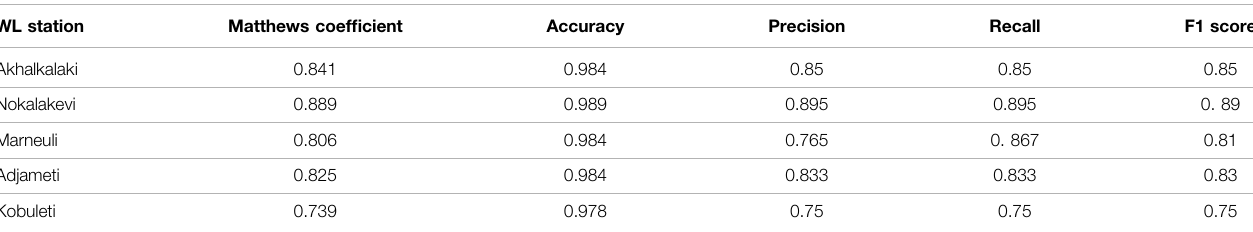
TABLE 3 | Classi fi cation performance measures in EQ forecast: MCC, accuracy, precision, recall, and F1 WL station